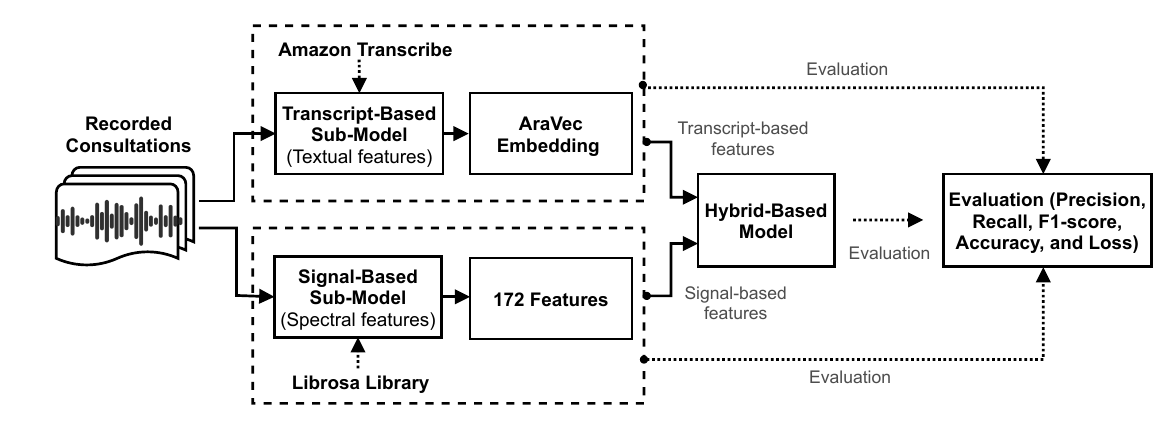
Figure 4. A schematic overview of the conducted